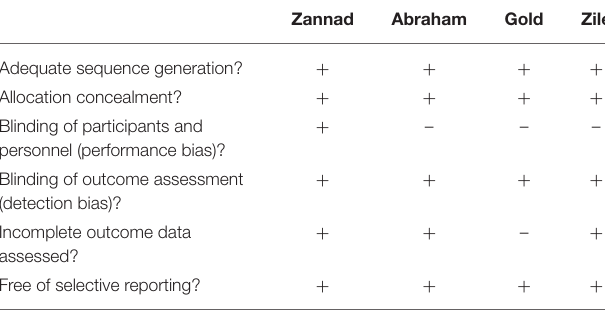
TABLE 1 | Search strategy. TABLE 2 | Risk of bias of the included randomized controlled